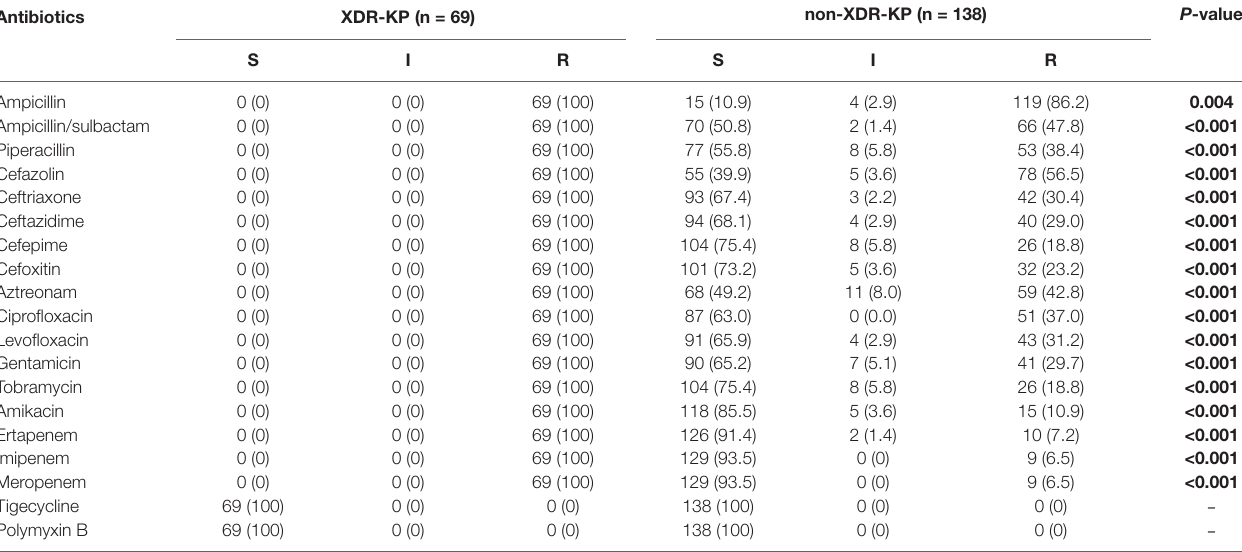
TABlE 1 | The antimicrobial susceptibility of extensively drug-resistant Klebsiella pneumoniae (XDR-KP) and non-XDR-KP. Antibiotics